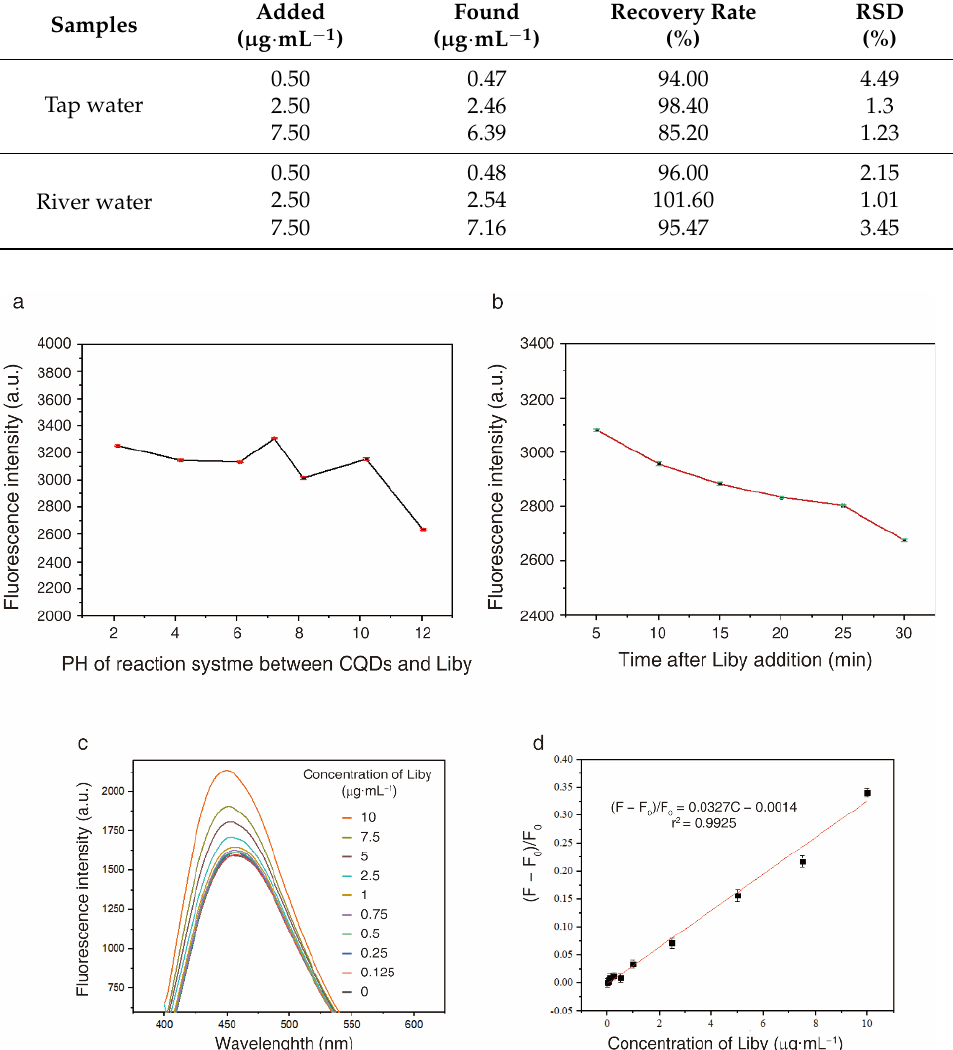
Figure 8. Fluorescence intensity of CQDs and 2.5 µ g · mL − 1 Liby solution measured ( a ) under different pH conditions and ( b ) at the indicated timepoints after Liby addition. ( c ) PL spectra of CQDs and Liby solution. ( d ) Fluorescence intensity (F 0 ) of CQD solutions and the fluorescence intensity (F) of CQD solutions containing different concentrations (C) of Liby. A linear regression equation was obtained. All experiments were repeated three times. Results are expressed as mean ± standard deviation